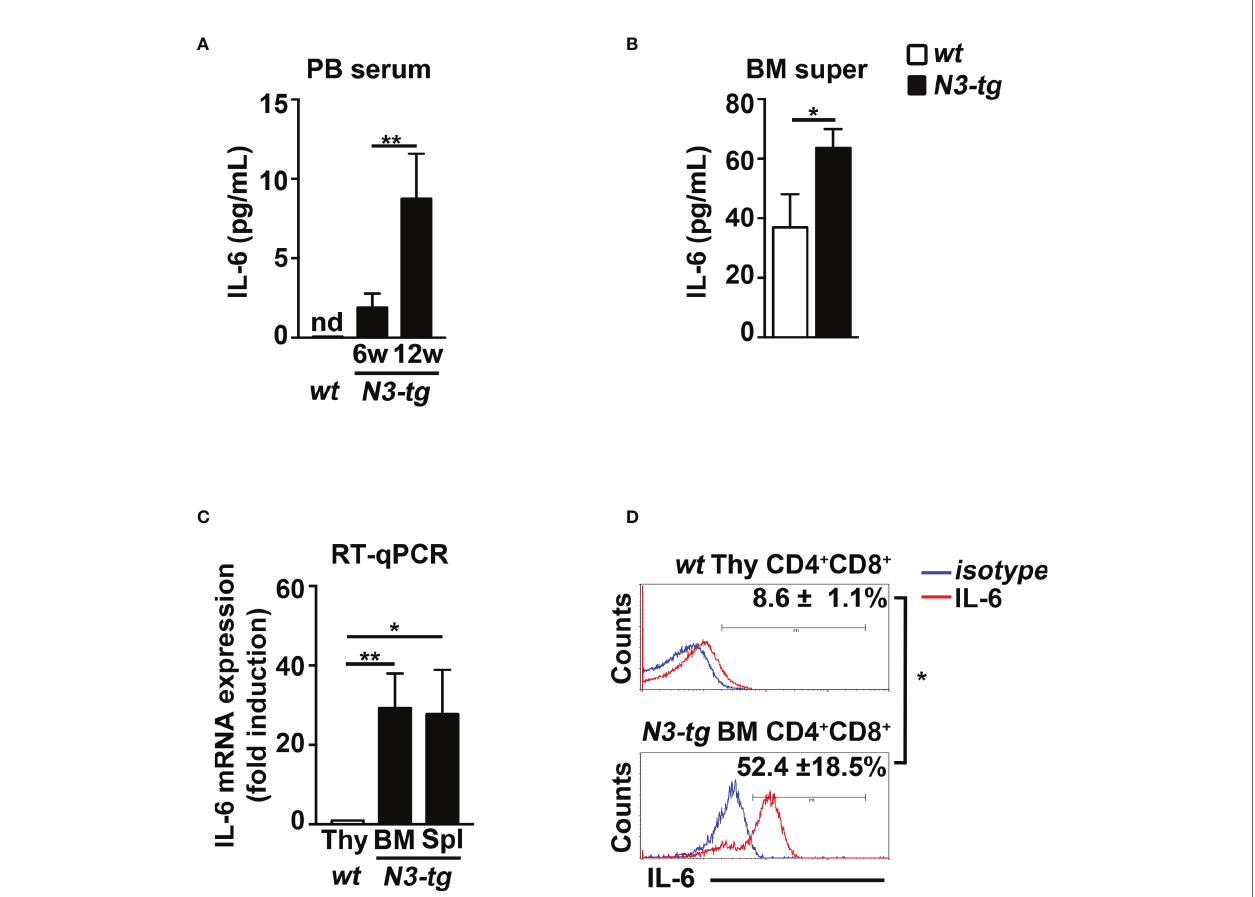
FIGURE 2 | N3-tg mice display high levels of IL-6. IL-6 protein concentration assessed by ELISA (A) in blood serum (PB serum), from N3-tg vs. wt mice at 6 and 12 weeks of age, and (B) in BM supernatant (BM super), from N3-tg vs. wt mice at 12 weeks of age. (C) RT-qPCR of relative IL-6 mRNA expression in DP T cells sorted from BM or spleen (Spl) of N3-tg mice or from wt thymus (Thy), as a control, at 12 weeks of age. IL-6 mRNA expression levels in wt DP thymocytes are set as 1. (D) Representative FACS analysis of intracellular IL-6 staining in DP T cells from N3-tg BM or from wt thymus (Thy), at 12 weeks of age, upon 4 h of PMA/ ionomycin stimulation (red lines). Blue lines, isotype controls. Numbers inside cytograms represent mean percentages ± SD of IL-6 + cells inside CD4 + CD8 + subset. The values are presented as mean ± SD from three independent experiments ( n = 4 mice per group), and in (A – C) with three technical replicates per experiment. nd, not detectable; * p ≤ 0.05 and **p ≤ 0.01 represent signi fi cant differences between the indicated